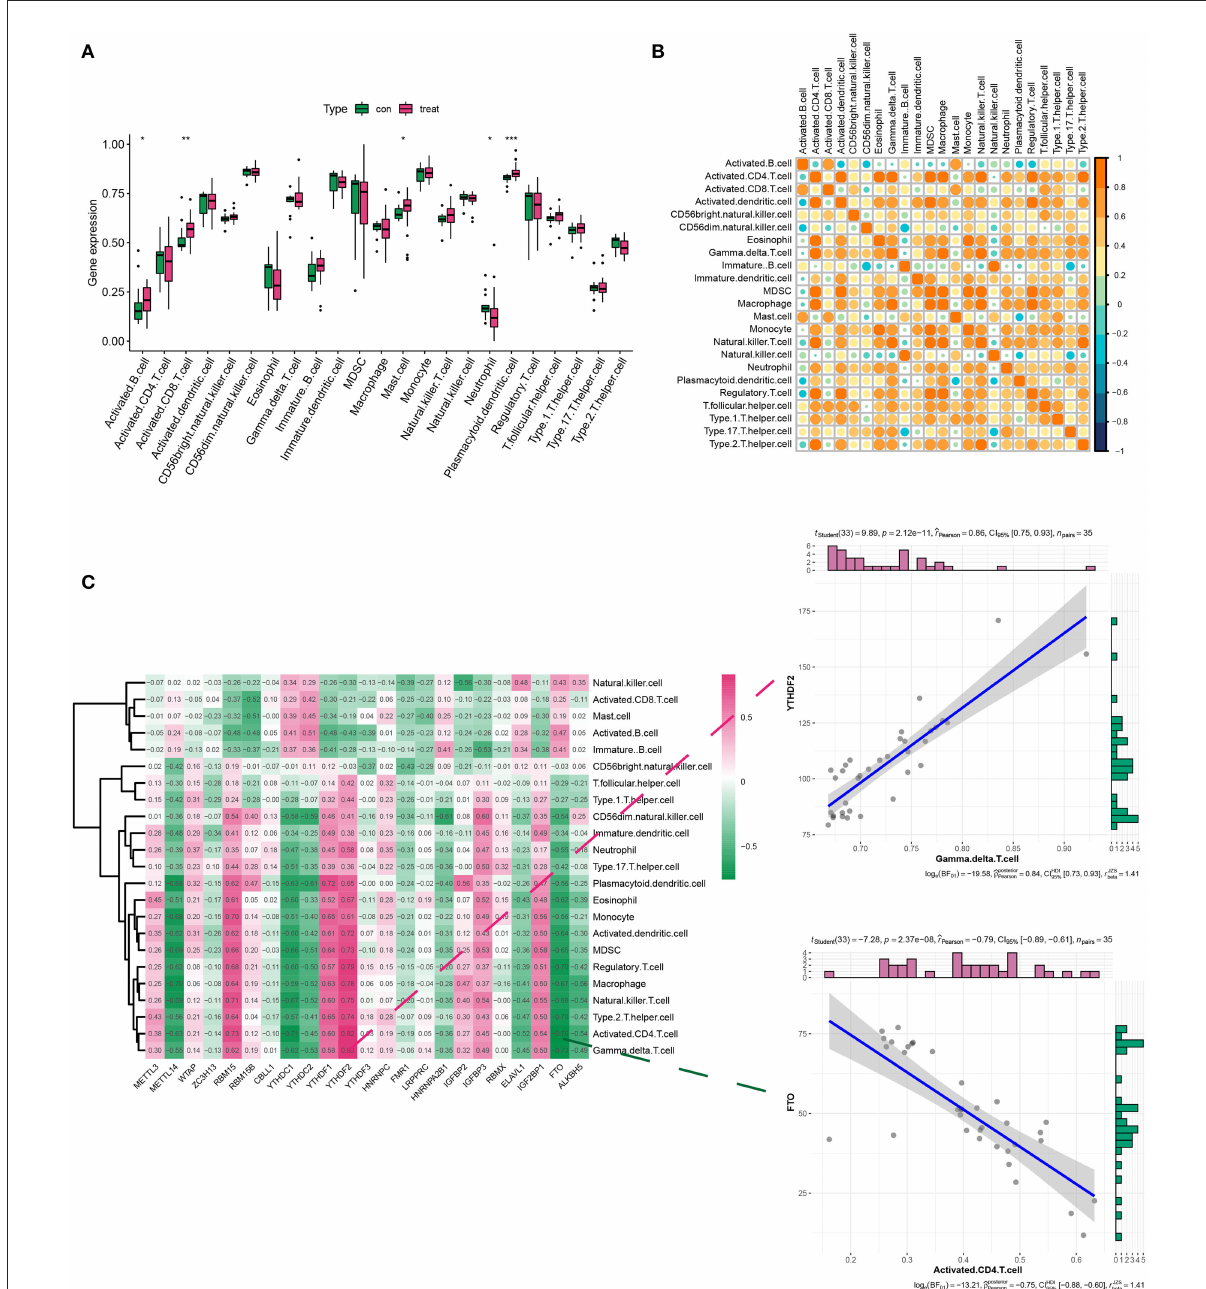
FIGURE2 Analysis of immune infiltration in the healthy and AD groups. (A,B) The box plot and heatmap plot displayed various immune cell infiltration between the healthy and AD groups. (C) The correlation between m6A genes and immune infiltration cells in AD. The two scatter plots demonstrated the most positive related immunocyte-m6A regulator pair was YTHDF1- γδ T cell, while the most negative immunocyte-m6A regulator pair was FTO-activated CD4 + T cell. * p < 0.05, ** p < 0.01, *** p < 0.001 indicated the statistical significance of data.